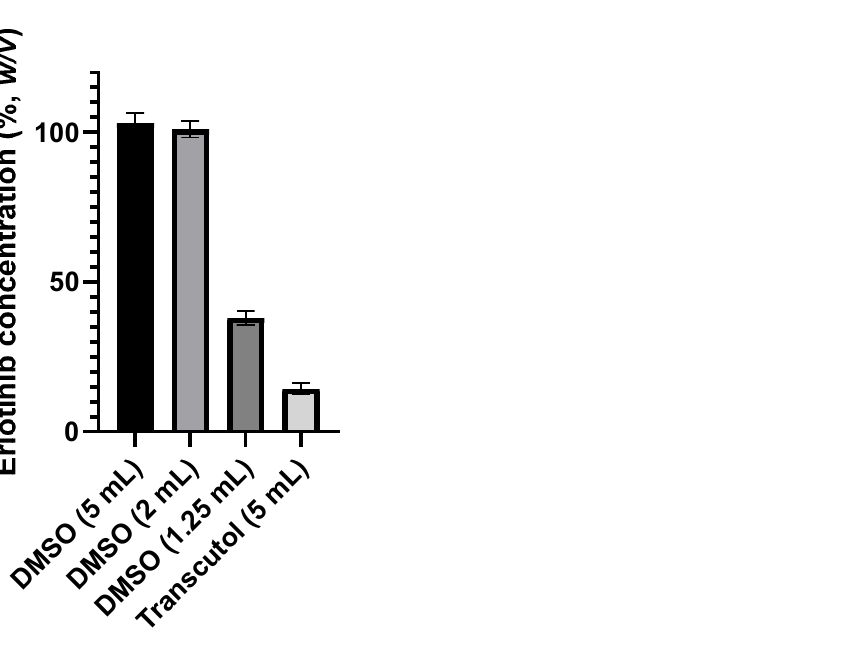
Figure 1. Erlotinib 100 mg tablet extraction recovery (%) yield as a function of DMSO (5; 2; 1.25 mL) and Transcutol ® (5 mL) volume. One extract was obtained for each condition and was analyzed three times.